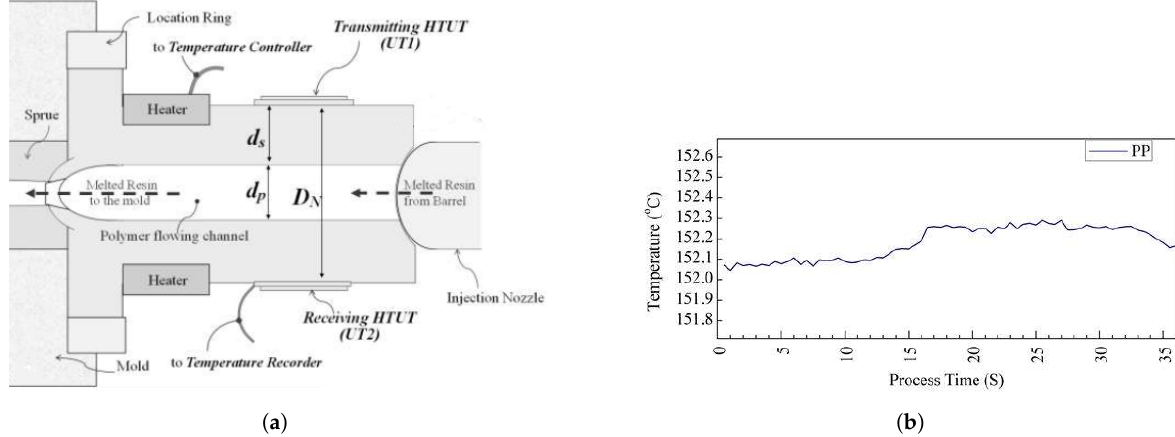
Figure 8. Fabricated sol-gel ultrasound sensor at the nozzle; ( a ) cross-section of the nozzle with the probes; ( b ) the measured temperature for PP by a thermocouple